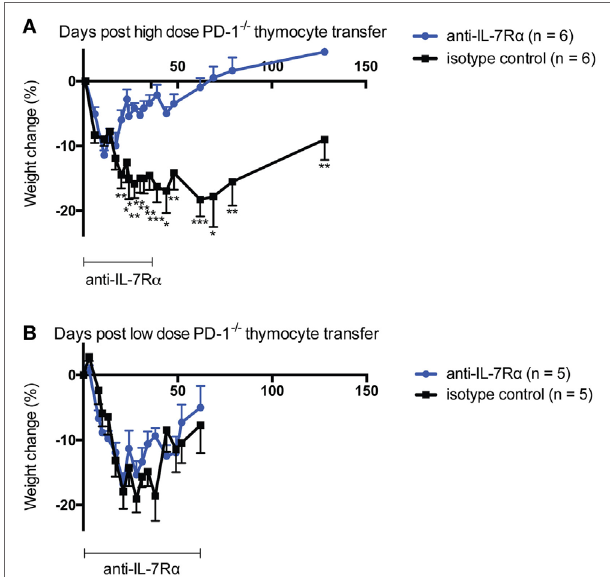
FigUre 4 | IL-7R α blockade ameliorates high- but not low-dose PD-1 − / − thymocyte-mediated morbidity in lymphopenic recipients. Either high-dose [panel (a) , 30 × 10 6 total cells] or low-dose [panel (B) , 10 × 10 6 total cells] PD-1 − / − unfractionated thymocytes were transferred to NK-depleted Rag − / − recipient animals with i.p. injection of 0.5 mg per mouse anti-IL-7R α or isotype control twice weekly for the time periods indicated. Mice were monitored for disease symptoms and loss of weight. (a) Weight change in high-dose thymocyte recipients over the experimental period. (B) Weight change in low-dose thymocyte recipients over the experimental period. * p < 0.05, ** p < 0.01, *** p < 0.001, Student’s t -test. The data depict the mean ± SEM of individual biological replicates from one